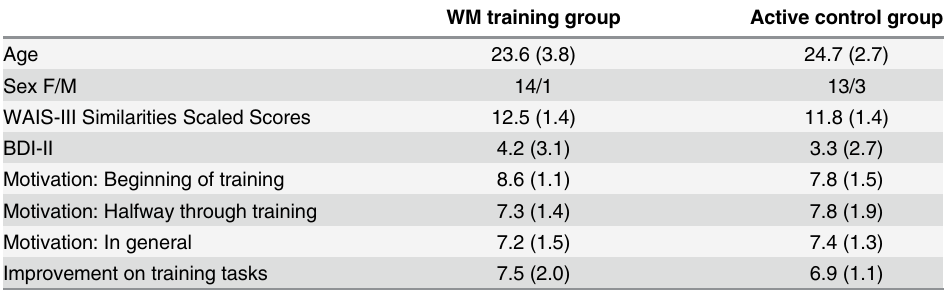
Table 1. Descriptive data on the study